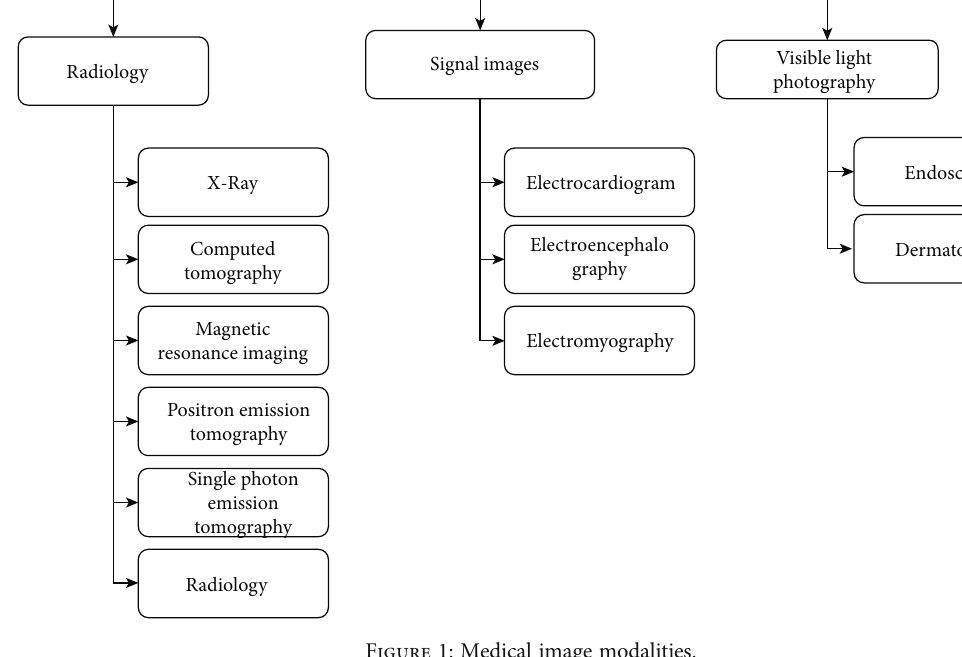
Figure 1: Medical image modalities.